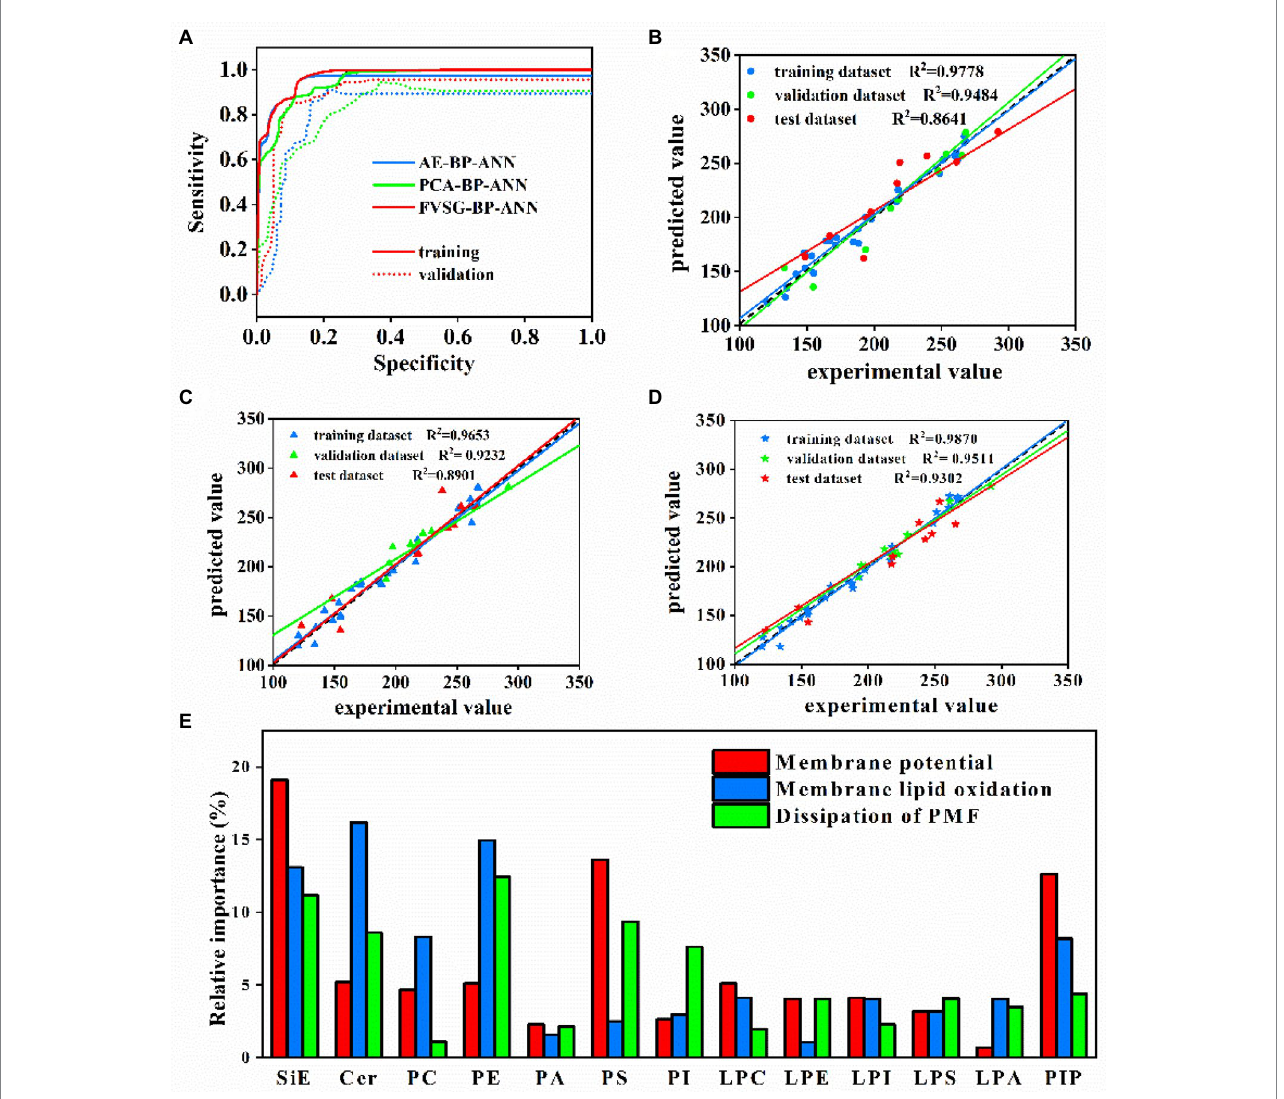
FIGURE 6 (A) Training and validation AUCs of 3 BP-ANN models. (B) PCA-BP-ANN, (C) AE-BP-ANN, and (D) FVSG-BP-ANN predictions of membrane potential vs. experimental values during training, validation, and testing. (E) Relative importance analysis (variations of membrane lipids as the input data to membrane properties as the output